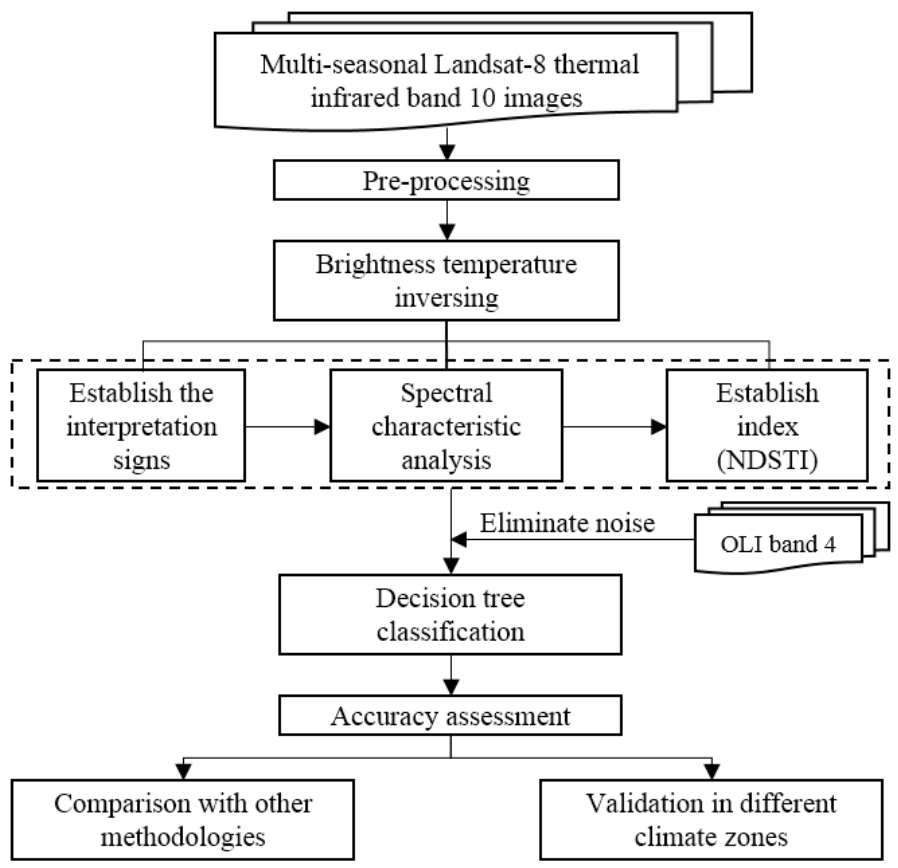
Figure 1. Flowchart of the extraction for the built-up area.